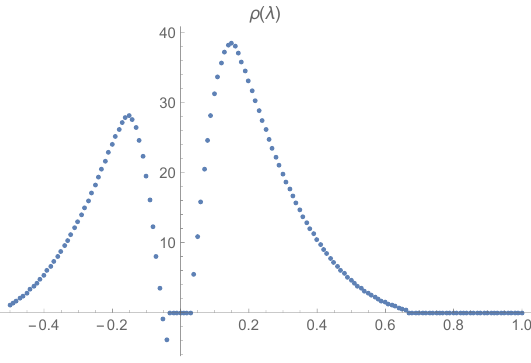
. We use here L W